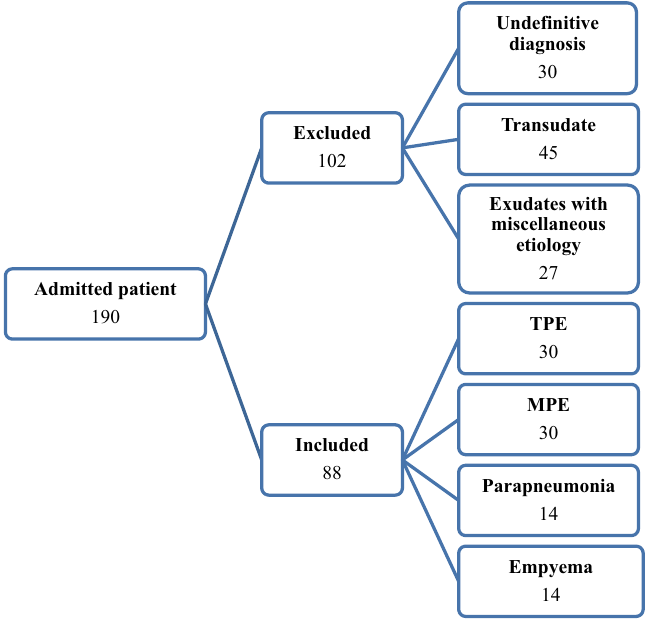
Figure 1. Flow chart of study groups.